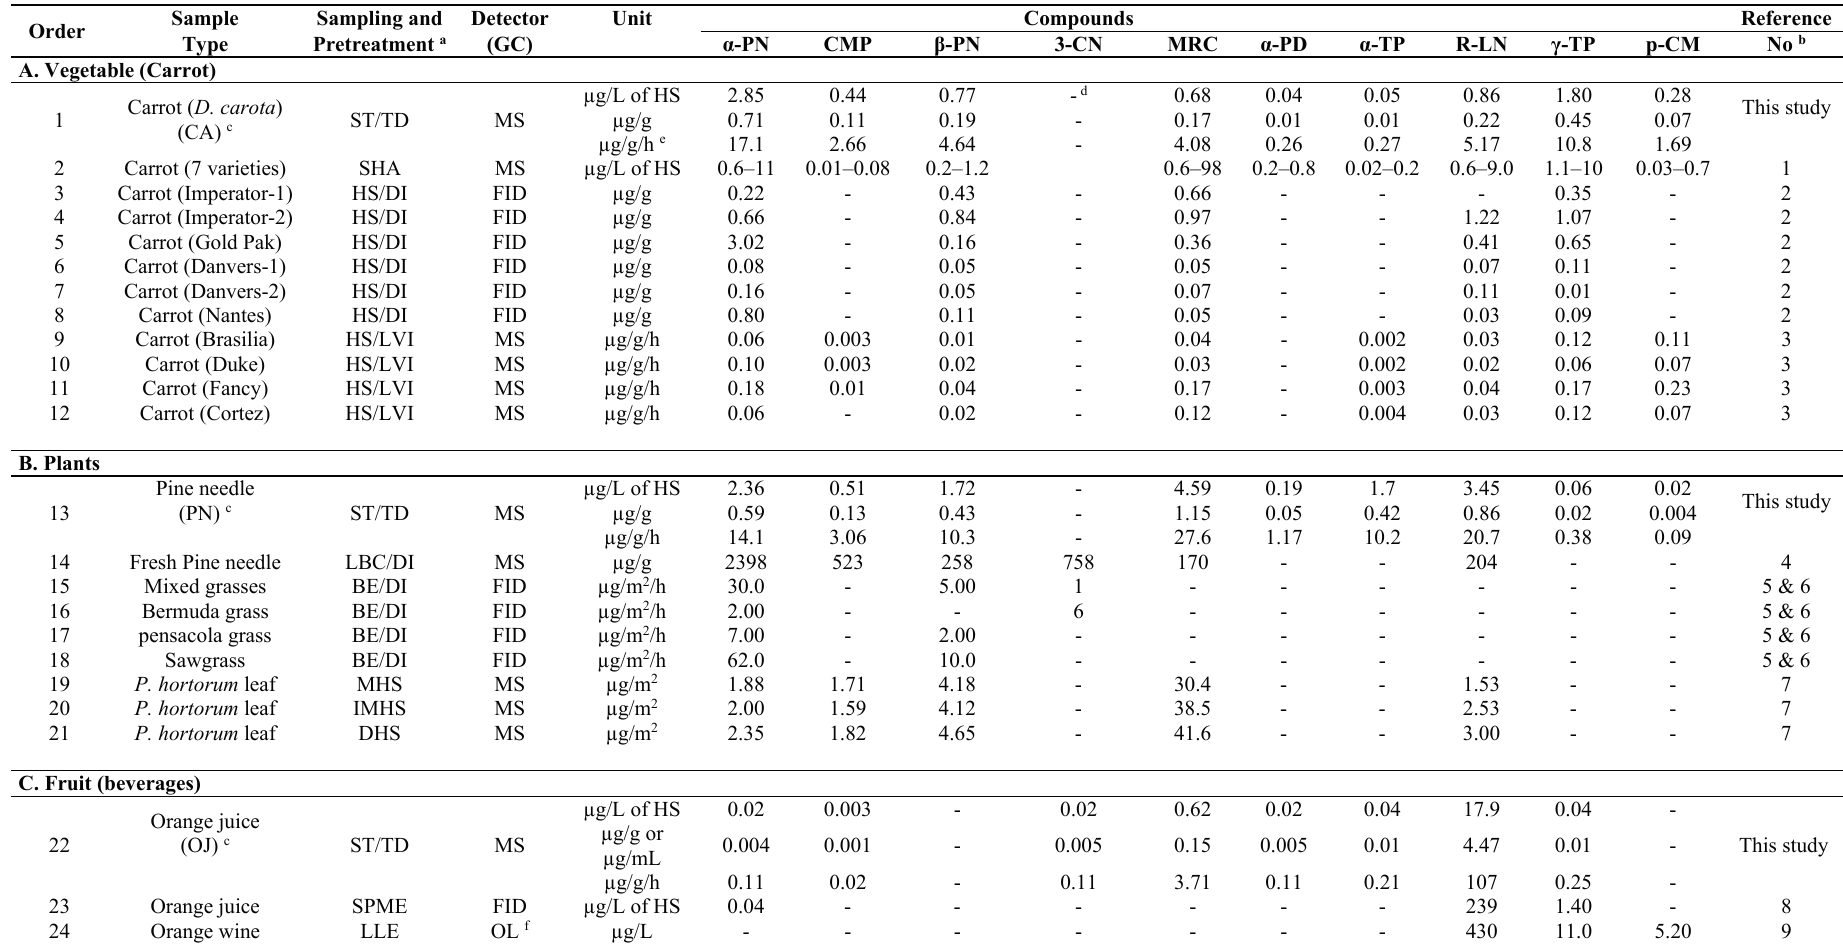
Table 3. Comparison of MT emission data between different